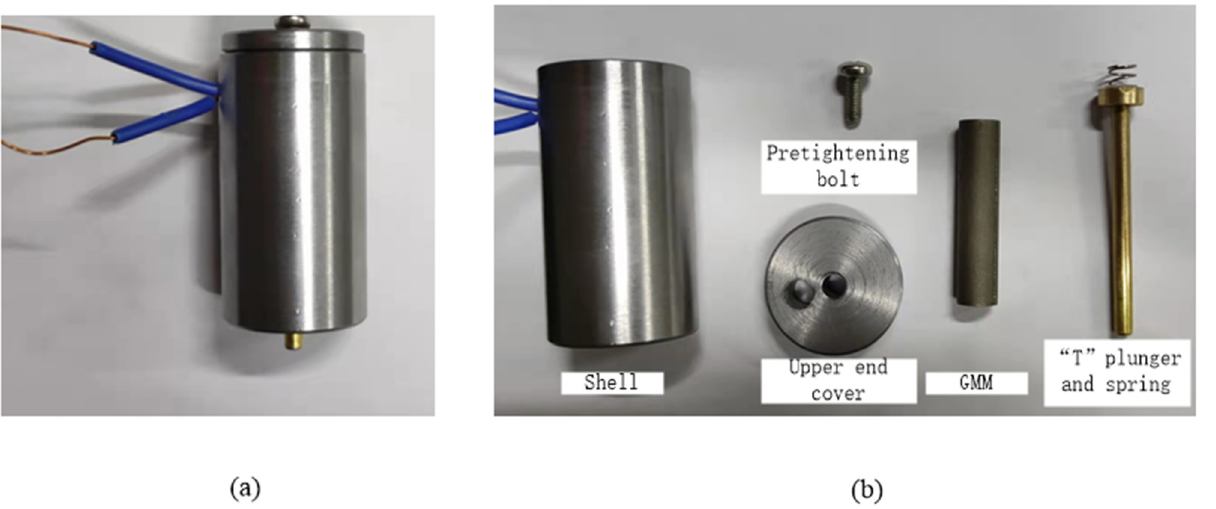
Figure 20. GMA physical drawing. ( a ) GMA device overall drawing, ( b ) GMA device exploded view.